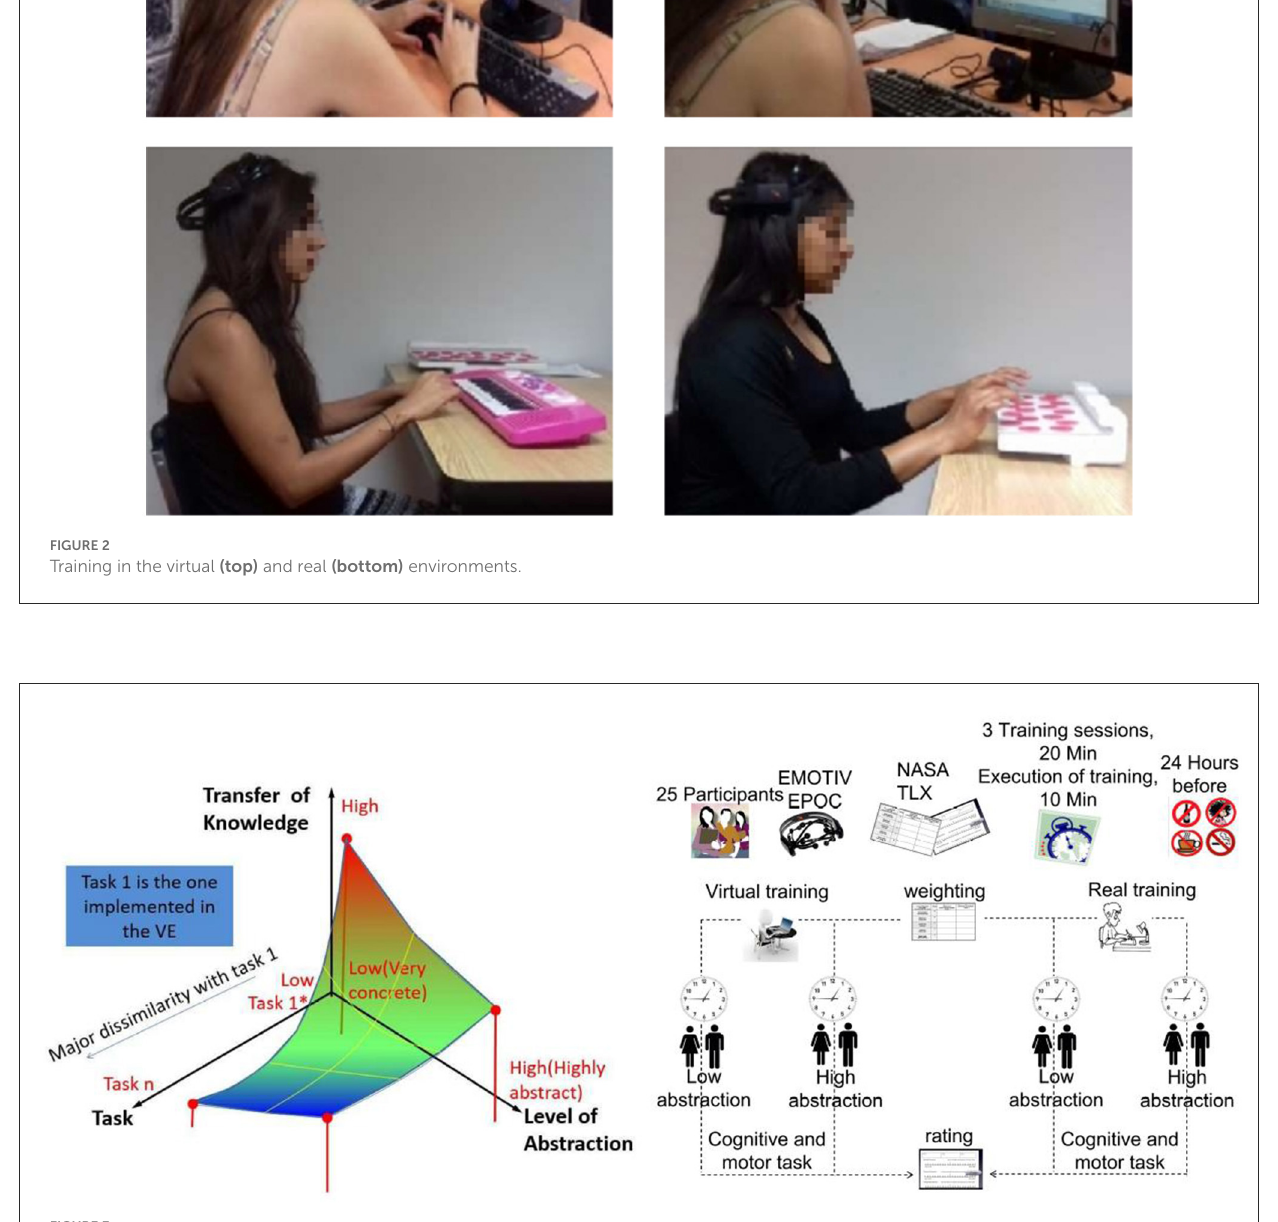
FIGURE3 (Left) Schematic representation of the hypothesis: when the level of abstraction in a task is low, a high transfer of knowledge is reached but it compromises the mobilization of knowledge toward other task. When the level of abstraction in a task is high, the transfer of knowledge occurs in a moderate way but the skills to face other task are improved. (Right) Representation of the experimental design: on the top, cohort size, assessment tools, and procedure are indicated. On the lower part, the training path followed by the groups is